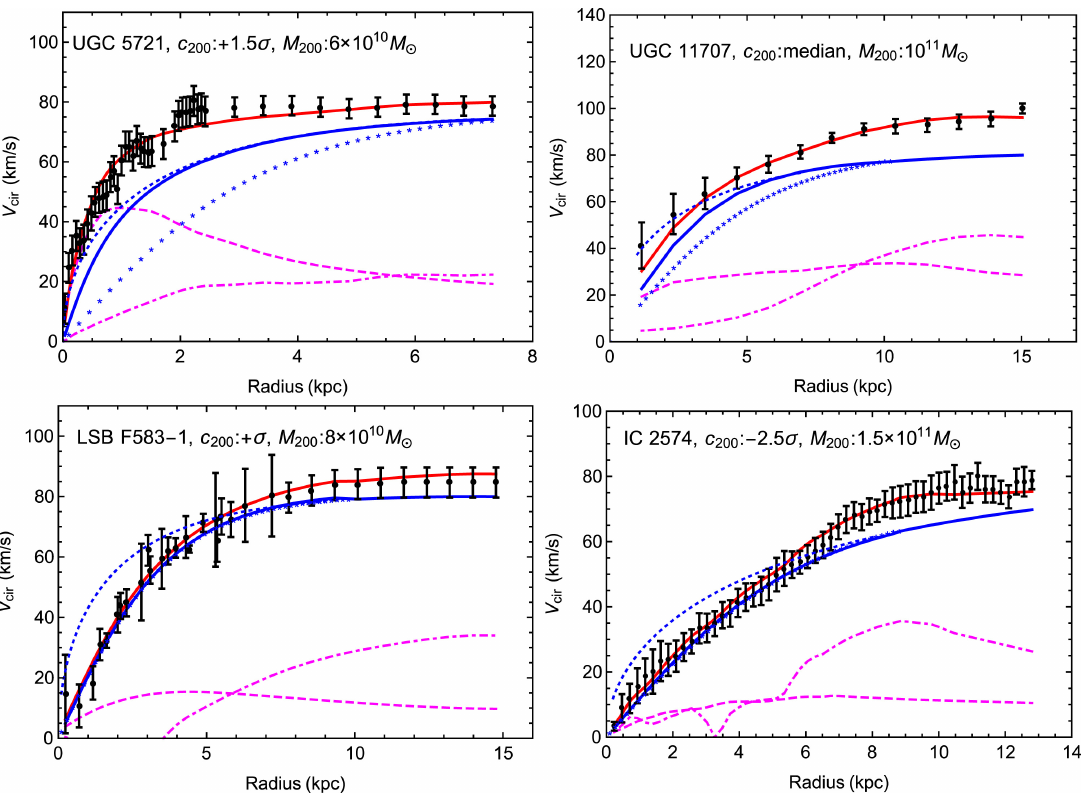
Figure 19. Observed rotation curves of four disk galaxies. Solid red lines indicate the total rotation curves for SIDM with σ / m = 3 cm 2 /g which include contributions from the dark-matter halo (solid blue), stars (magenta dashed), and gas (magenta dot-dashed). The corresponding CDM halos (dashed blue) and SIDM halos (blue stars) neglecting the baryons are also shown. The concentration parameters c 200 are indicated in terms of the standard deviation from the median cosmological concentration of halos of mass M 200 . The figure is reproduced from